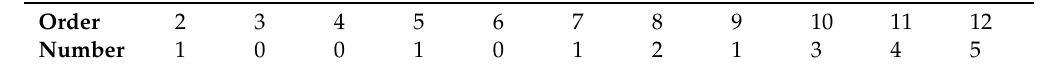
Table A1. The number of independent domination stable trees with different orders. Order